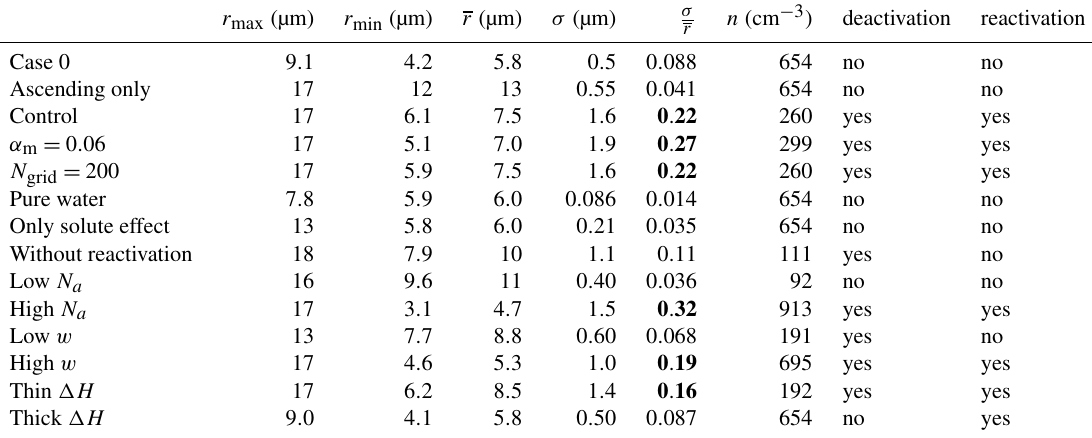
Table 2. Microphysical properties at cloud top for different cases: r max is the largest cloud droplet radius in a moving size grid, r min is the smallest cloud droplet radius in a grid, r is the mean cloud droplet size, σ is the standard deviation of the droplet radius, σ/r is the relative dispersion and n is the cloud droplet number concentration. Case 0 is when the cloud parcel reaches the cloud top for the first time with the same setup as the control case (shown as black circle in Fig. 3). For other cases, results represent the parcel at cloud top for the last time after 3h simulation; an example of the control case is shown as the green circle in Fig. 3. Bold values represent cases of broader cloud droplet size distribution with relative dispersions larger than 0.15.